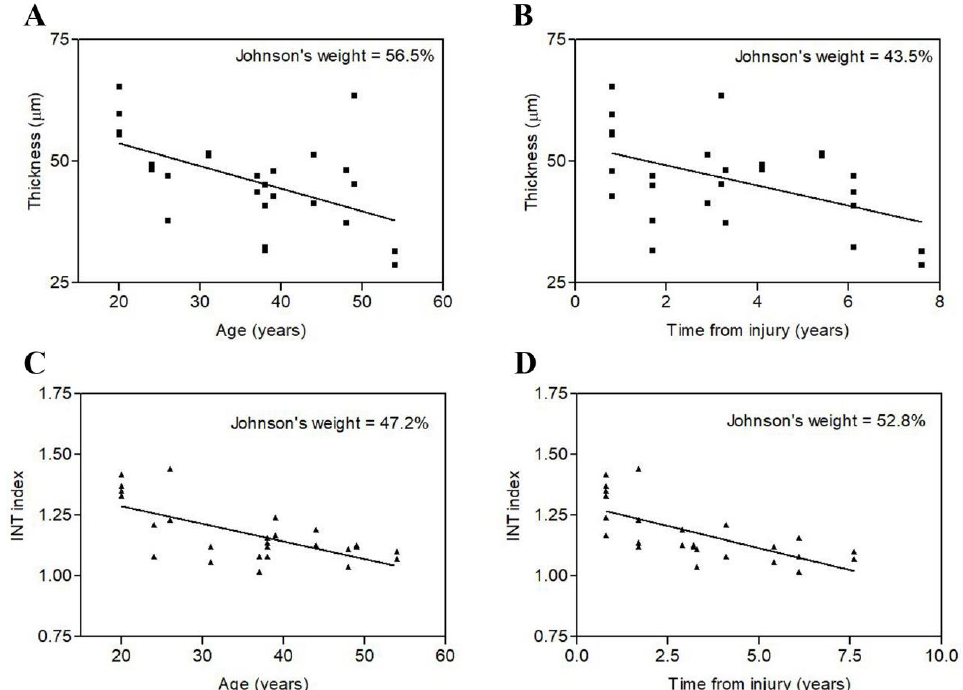
Figure 2. Multiple regression analysis on LMNSCI before the h-bFES, indicating a moderate (R < 0.7) but significant ( p < 0.01, see Table 2) change of epidermis thickness with both age ( A ) and time from injury ( B ) and change of Interdigitation index (INT index) with both age ( C ) and time from injury ( D ). The indicated Johnson’s weight estimates the relative impact of each of the two factors on the multiple correlation factors.